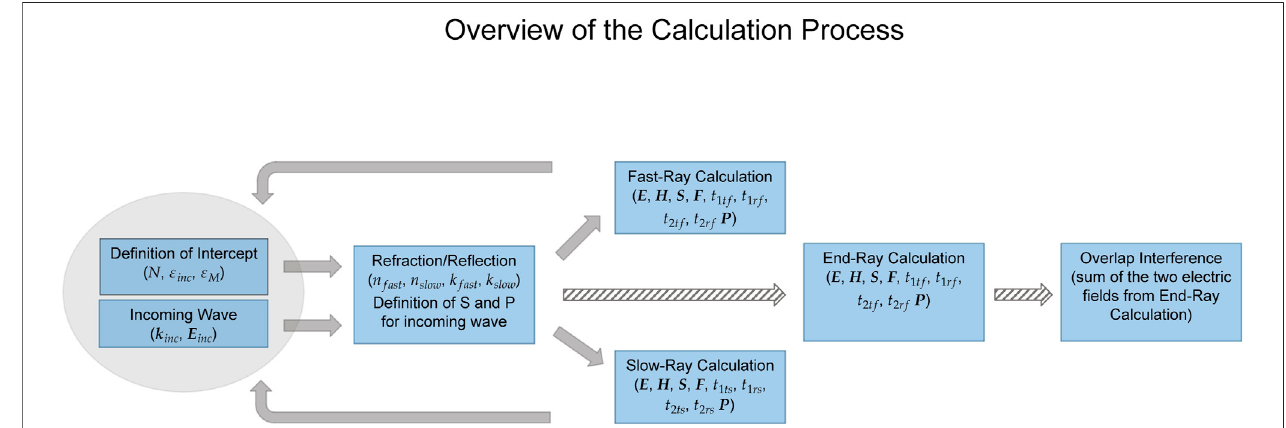
FIGURE 3 | Process chart of the code-implementation. From the two initial settings of input-ray and intercept, the refraction indexes and wavevectors of refracted and re fl ected rays are calculated. The derivation of the fi eld-vectors is separately done for the fast and slow solution and serves as input for the exit-intercept (for details regarding F , please refer to the Supplementary Appendix ). From both fast and slow solution after the exit-intercept, the fi eld-vectors are calculated ( “ end-ray calculation ” ) and their overlap interference determined.